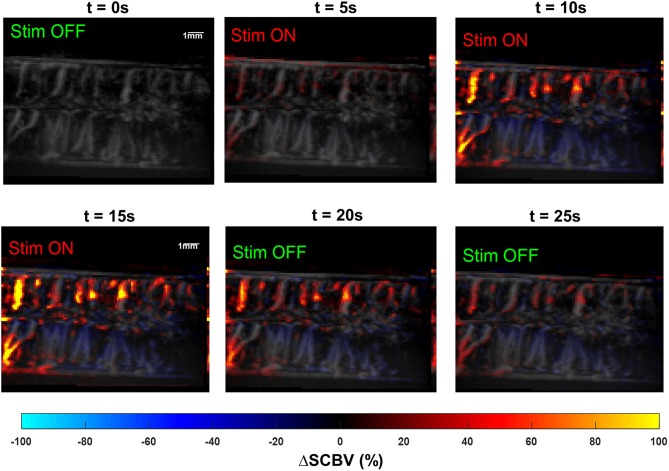
Snapshots of the fUS movie of the swine spinal cord response to SCS. The movie is provided in Supplemental Video 5.